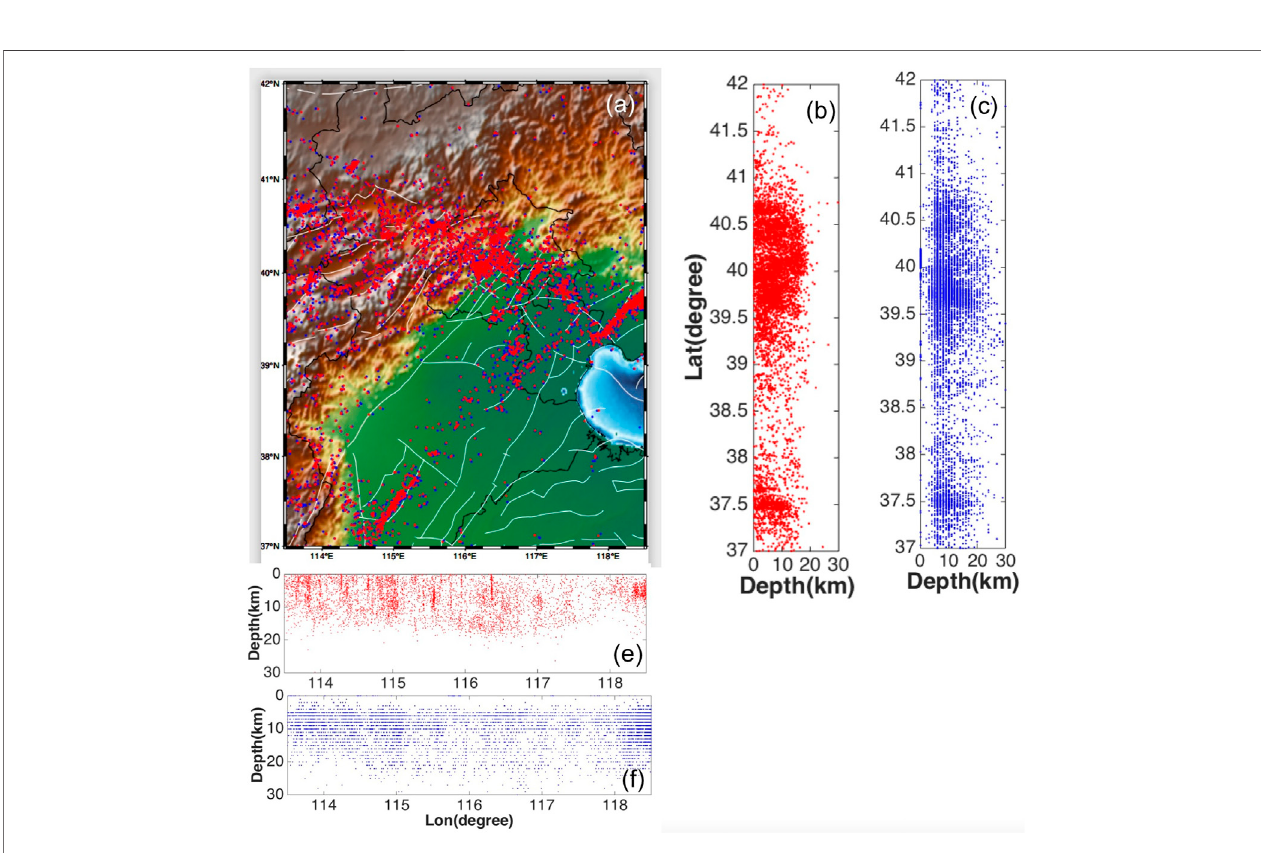
Frontiers in Earth Science |